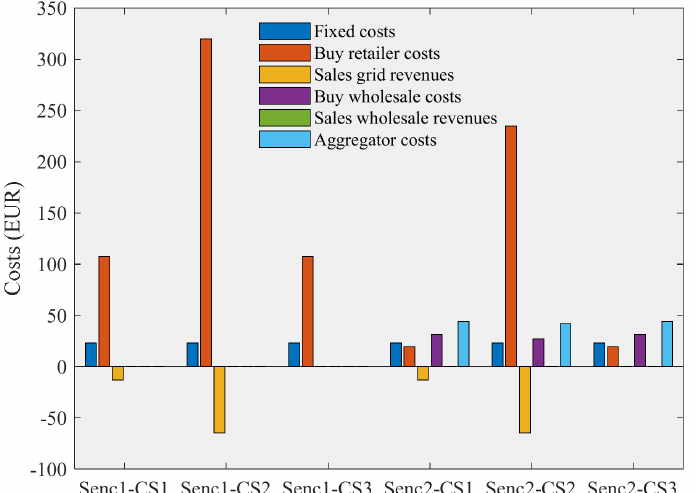
Figure 8. Energy costs comparison for all scenarios.